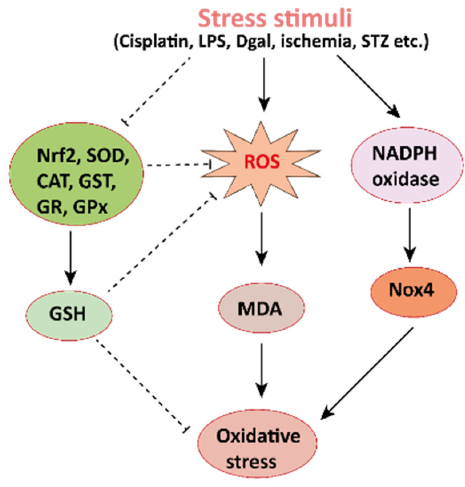
Figure 2. Mechanisms involved in the pathogenesis of oxidative stress in the kidney. NADPH oxidase is the main source of cellular ROS. Nox4 is an isoform of NADPH oxidase expressed in renal tubules that leads to oxidative stress (ROS and MDA) and damages the kidney. Stress stimuli, for instances cisplatin, STZ, ischemia result in decreased Nrf2 thus leading to oxidative stress. Reactive oxygen species, ROS; MDA, malondialdehyde; streptozotocin, STZ; NF-E2-related factor 2, Nrf2.